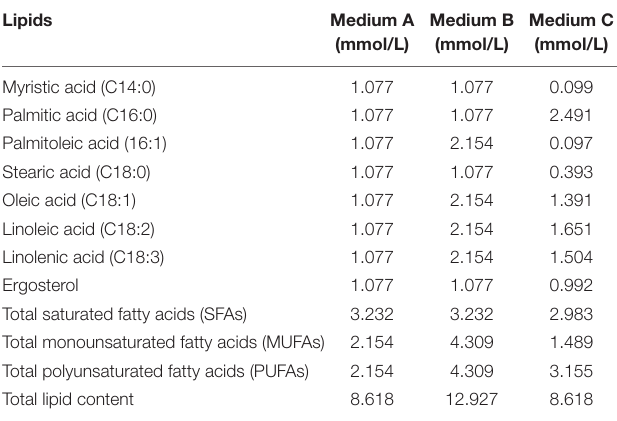
TABLE 2 | Lipid mixtures used for alcoholic fermentation in synthetic grape juice-like media.